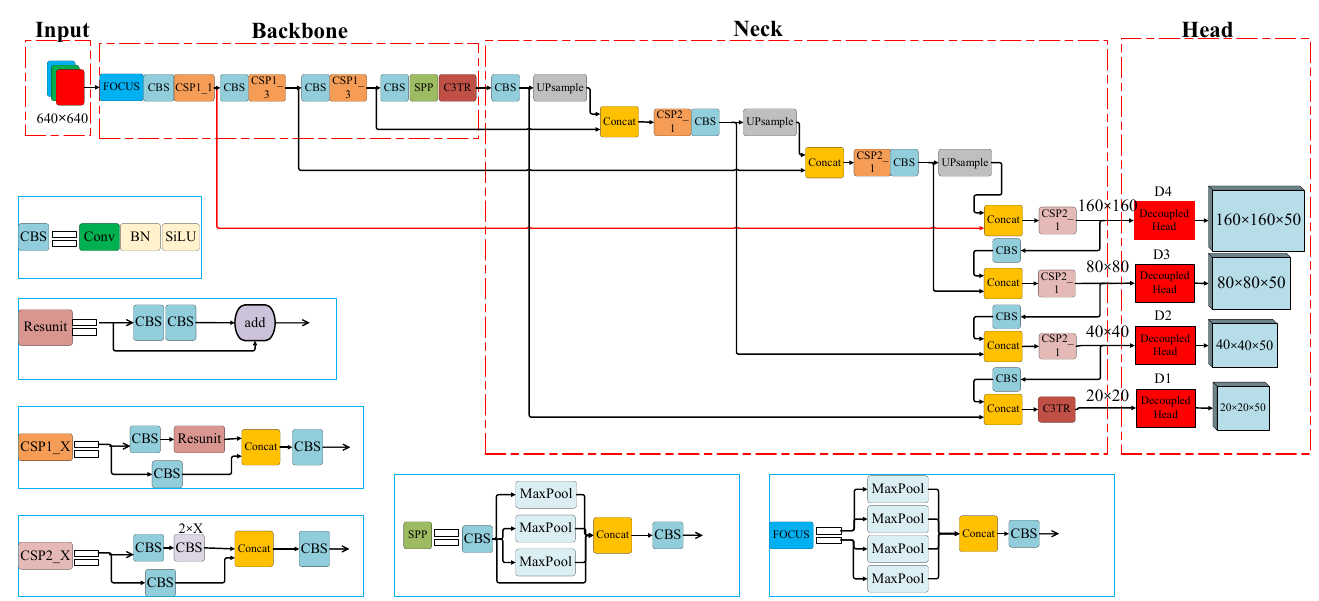
Figure 6. The structure of the proposed YOLOv5-TDHSA model.